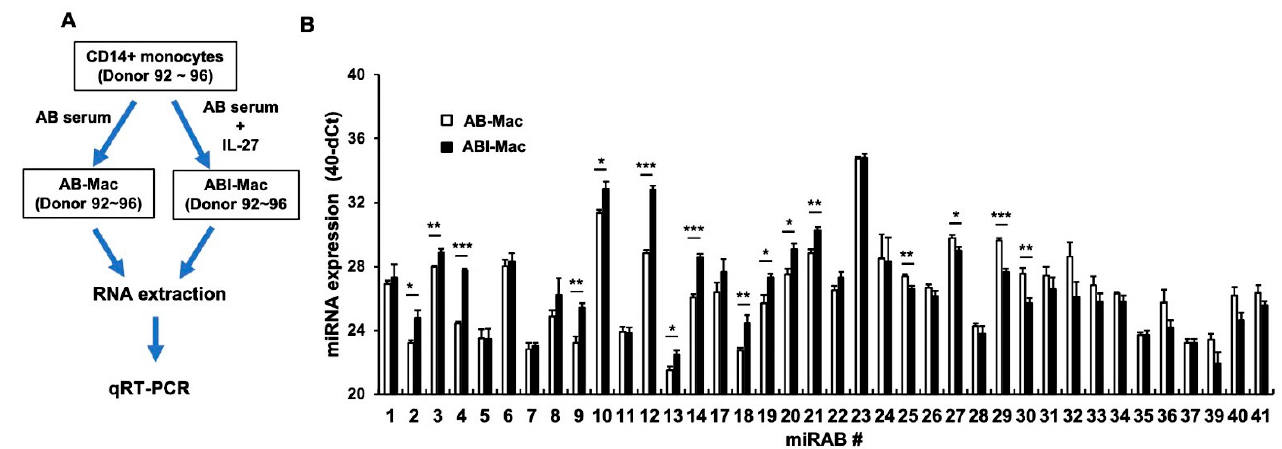
Figure 2. Confirmation and comparison of the expression of novel miRNA. ( A ) A diagram depicts the protocol for the qRT-PCA assay. Total cellular RNAs from AB and ABI-Mac from five independent donors (Donor 92~96) were extracted and then real-time qRT-PCR was performed using specific probes for each novel miRNA. ( B ) RNU44 was used as an internal control, and each miRNA expression was calculated delta-Ct (dCt) using Ct values in each novel miRNA and the RNU44, and then results are described 40-dCT. Results show mean of dCt ± standard errors (SE) ( n = 5). Gene expression level of each miRAB in ABI-Mac was compared to that in AB-Mac. *, **, and *** indicate p values are <0.05, <0.01, and <0.001, respectively.